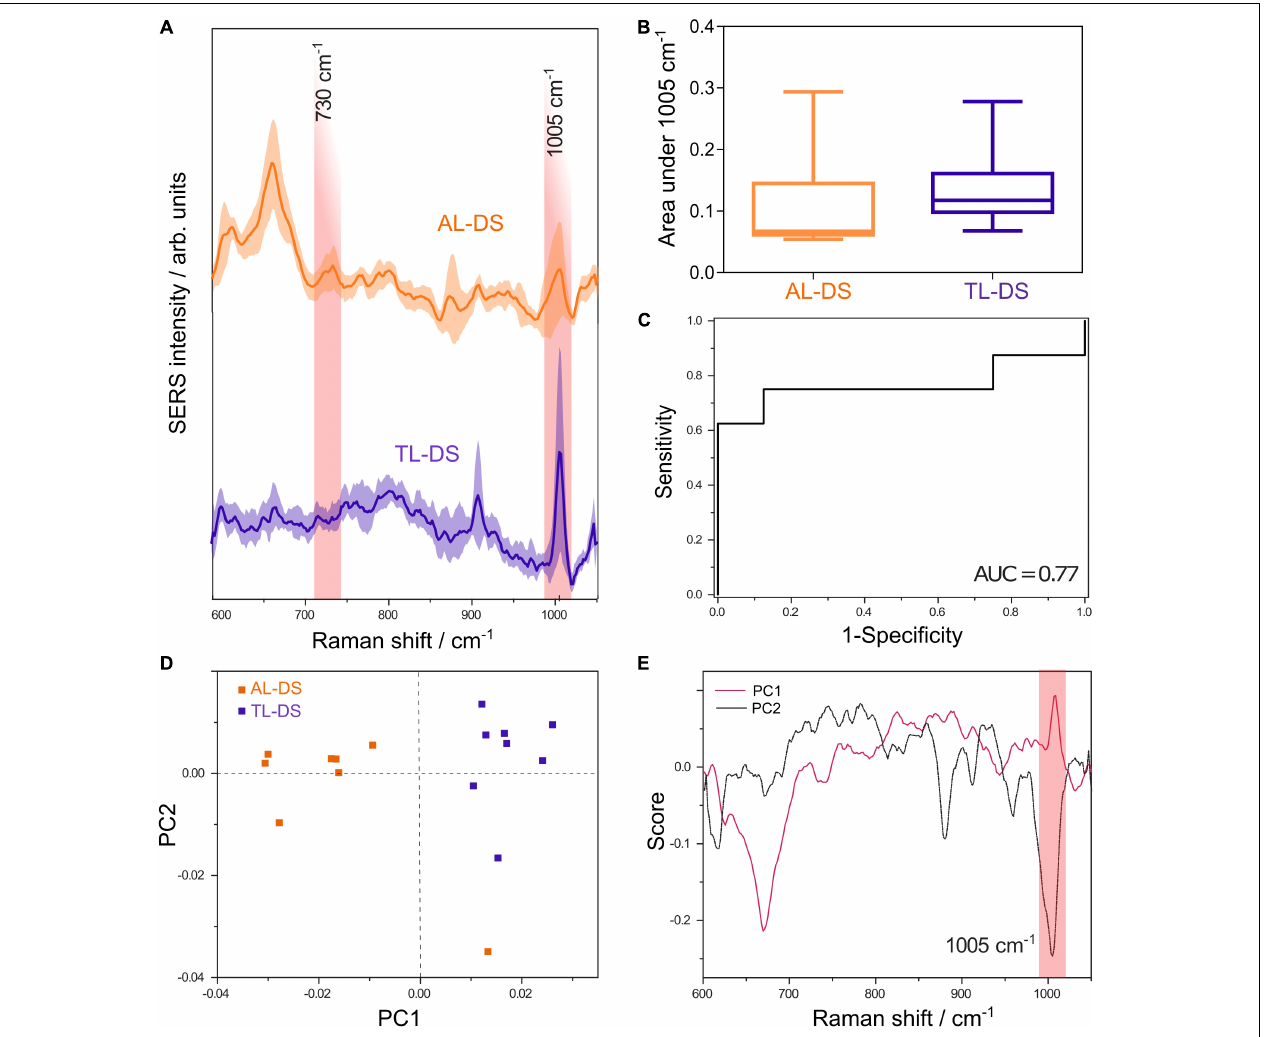
FIGURE 1 | (A) Average SERS spectra of DNA from patients with acute leukemia associated with Down syndrome (AL-DS) and transient leukemia associated with Down syndrome (TL-DS). (B) The average normalized area under the SERS band at 1005 cm - 1 attributed to 5-methylcytosine was lower for the AL-DS group compared to the TL-DS group (one tailed Mann-Whitney U test, p = 0.04). (C) ROC curve for differentiating between AL-DS and TL-DS based on the normalized area under the 1005 cm - 1 SERS band, yielding an AUC of 0.77 ( p = 0.07). (D) Score plot showing principal component (PC) 1 and PC2 resulted from the principal component analysis (PCA) of SERS spectra from AL-DS and TL-DS groups. (E) Loading plots corresponding to PC1 and PC2 from the PCA of SERS spectra from AL-DS and TL-DS